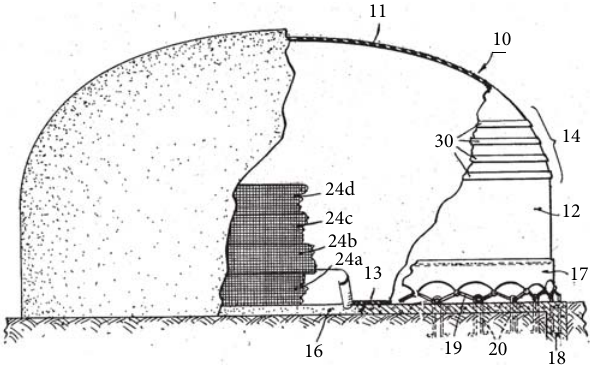
Figure 3: Concept drawing of Neff’s “improved method of erecting shell form concrete structures”